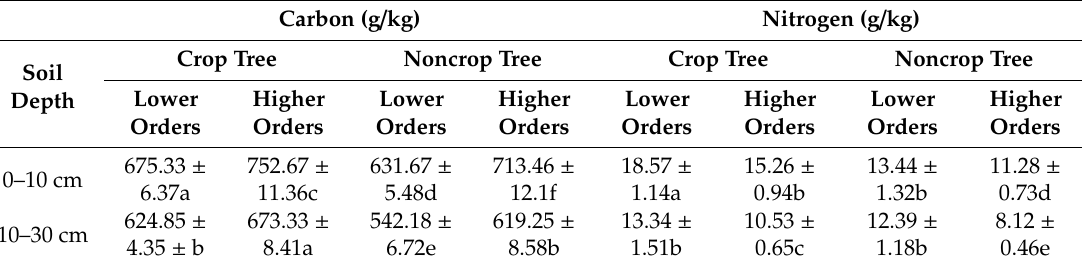
Table 4. Fine root carbon and nitrogen concentrations in Pinus